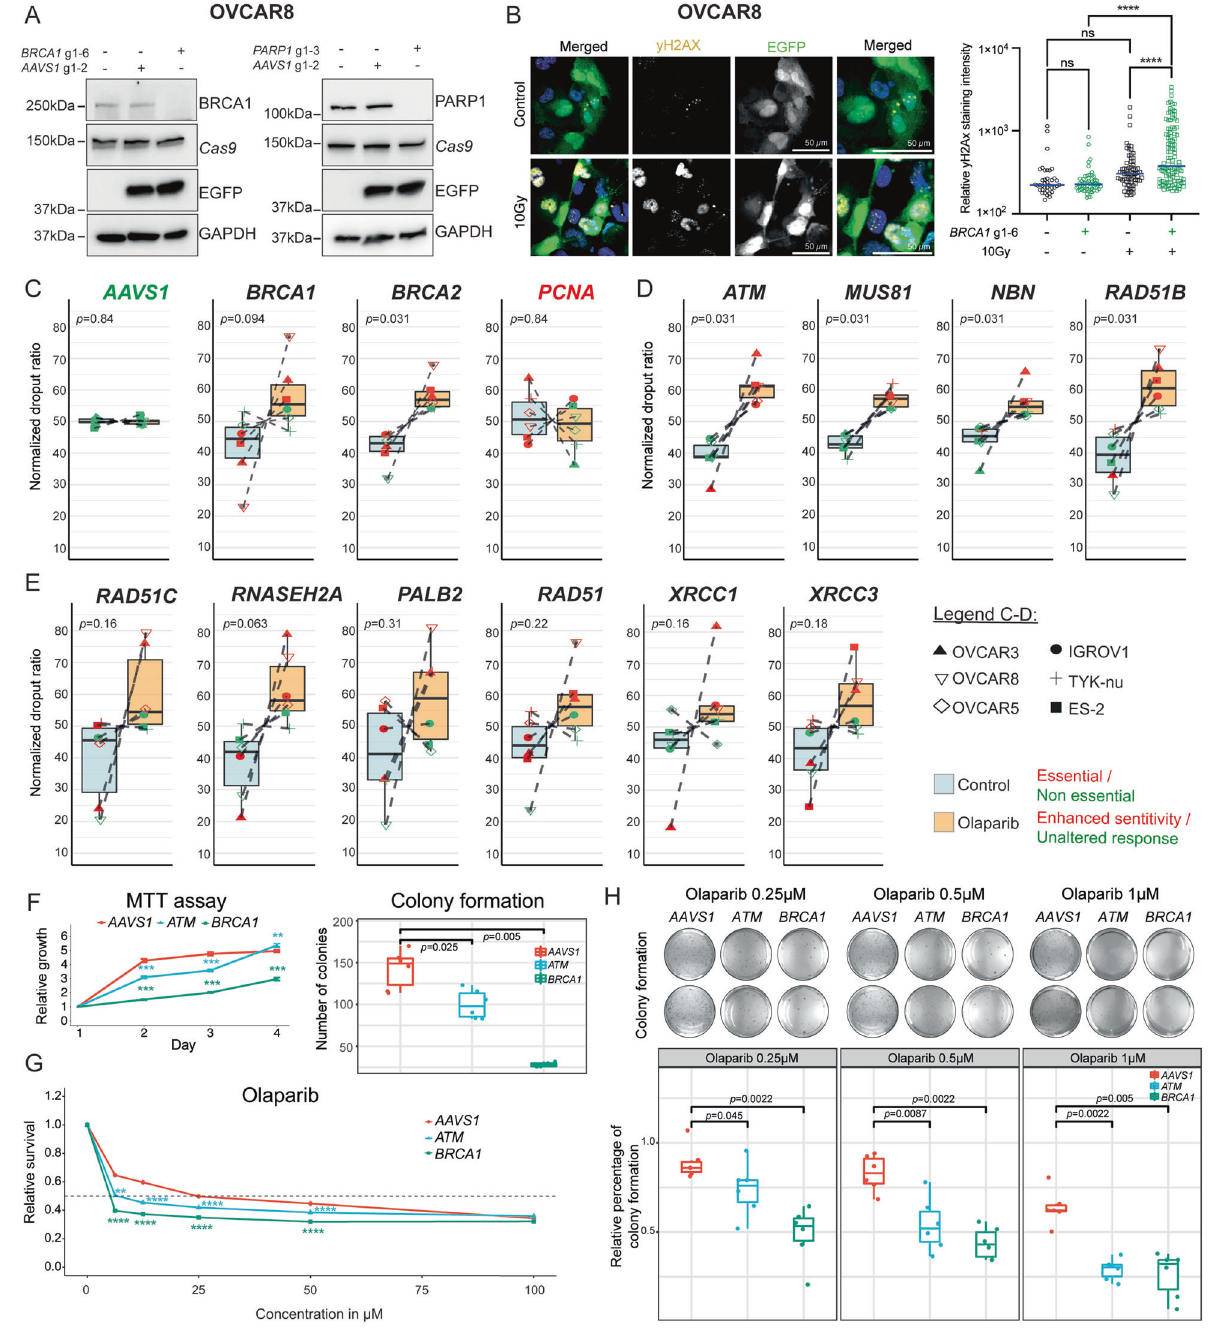
Fig. 3 Cancer cell fi tness and acquired olaparib sensitivity upon genetic deletion of speci fi c genes. A Representative Western blot con fi rming the loss of BRCA1 and PARP1 expression upon site-speci fi c deletion in OVCAR8- Cas9 + . B Gene-editing of BRCA1 impairs the DNA repair function. DNA damage was assessed by yHA2X staining in EGFP + (sgRNA speci fi c to BRCA1 ) and EGFP - cells (non-transduced cells). C Boxplots summarizing the impact on olaparib response in cell lines ( n = 6) upon gene deletion for negative ( AAVS1 ), positive ( PCNA ) controls, and clinically relevant genes BRCA1 and BRCA2 . The normalized dropout ratio was calculated by dividing the dropout value of the control part by the olaparib-treated part in passage 6. The threshold to de fi ne essential genes was delineated as >1.7 dropout rate in the non-treated conditions and is represented in red. Normalized dropout >55%, represents enhanced olaparib sensitivity and is represented in red. Olaparib concentration used was dependent on the cell line with the range of 0.25 – 1 µM. D , E Boxplots for targeted genes in all cell lines showing signi fi cant ( D ) and cell line-dependent ( E ) dropout upon olaparib treatment. F Results derived from MTT assay and matching colony formation assay ( n = 2 independent experiments), performed in sextuplicate and triplicates, respectively con fi rming a signi fi cant impact of BRCA1 deletion on cell fi tness in OVCAR8- Cas9 + cells. G Dose-dependent survival upon deletion of AAVS1 , ATM , and BRCA1 in olaparib treated OVCAR8- Cas9 + cells. H Matching colony formation with two representative wells in OVCAR8- Cas9 + cells with quanti fi ed colonies derived from two independent experiments. p -values were calculated by two-way ANOVA followed by Tukey ’ s multiple comparison test for B or Wilcoxon test for C – H , NS non-signi fi cant and ** p < 0.01, *** p < 0.001, **** p < 0.0001. See also Supplementary Figs. 6 and 7.